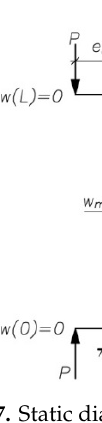
Figure 7. Static diagram of column.